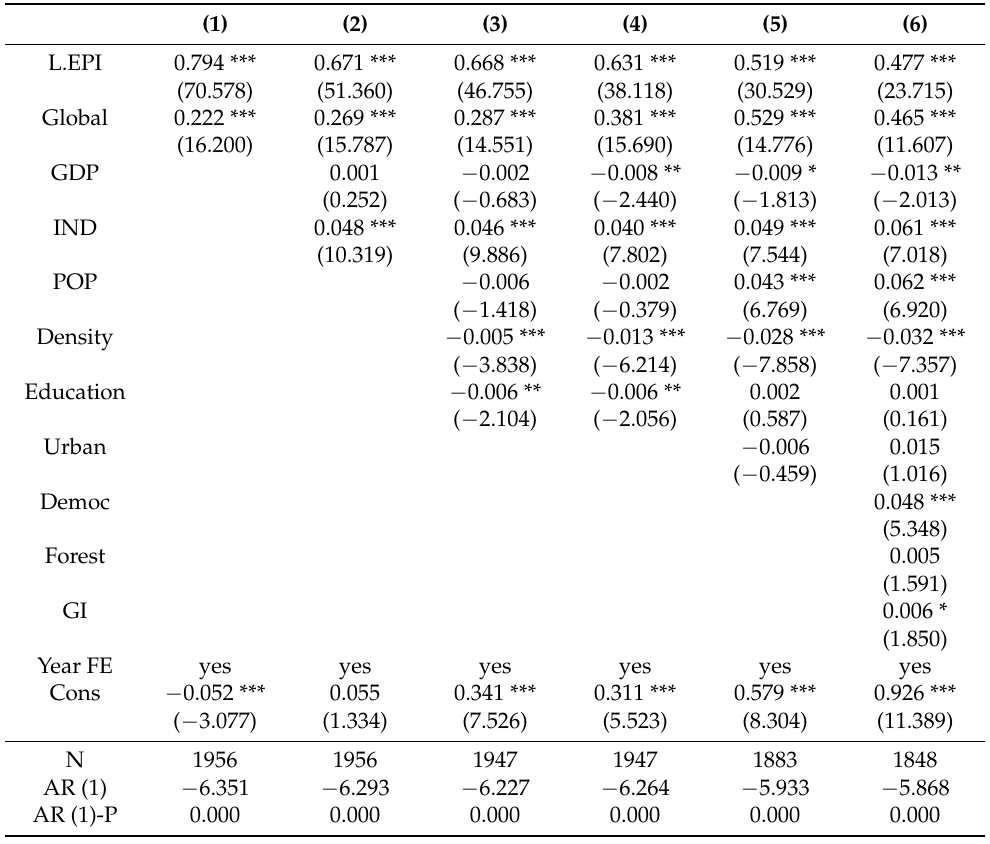
Table 3. The impact of globalization on EPI —SYS-GMM